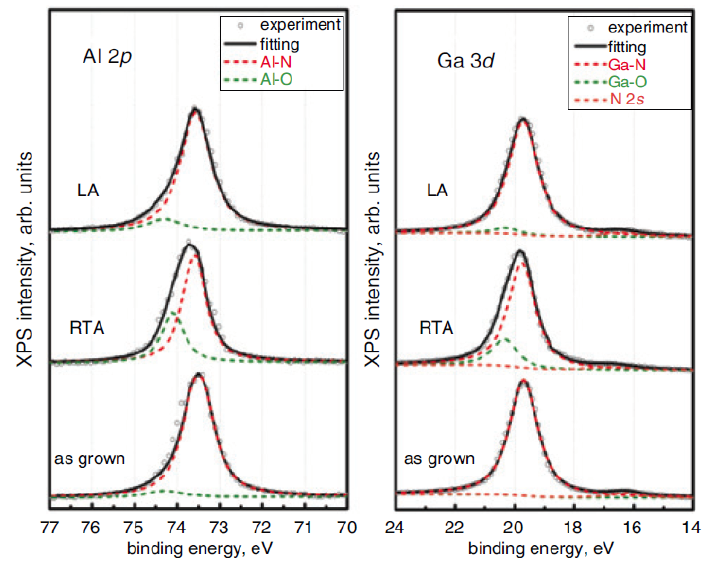
Figure 15. XPS core-level spectra of AlGaN surface as grown, after RTA and after the LA method. Reprinted with permission from Ref. [96]. Copyright 2019, Wiley.